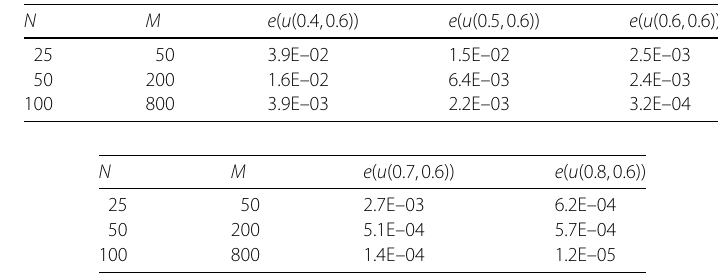
Table 1 The absolute error